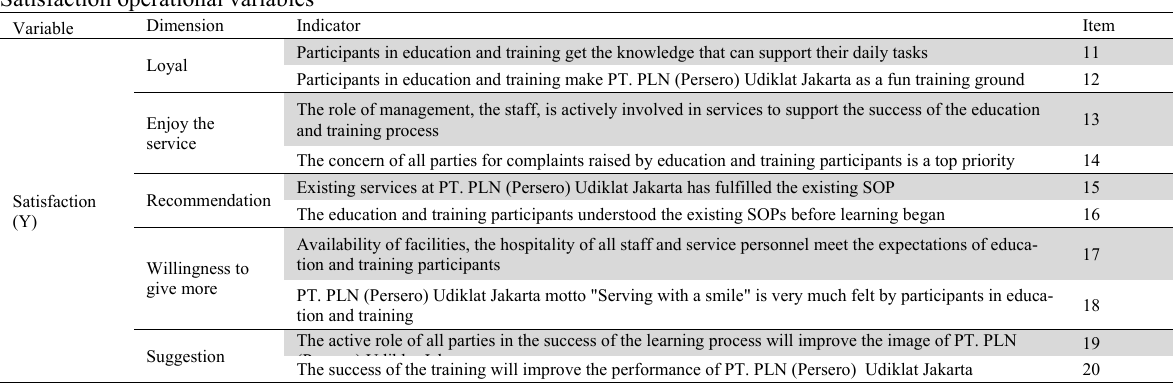
Satisfaction operational